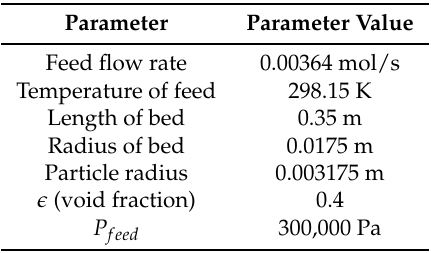
Table 10. Parameters for the PSA